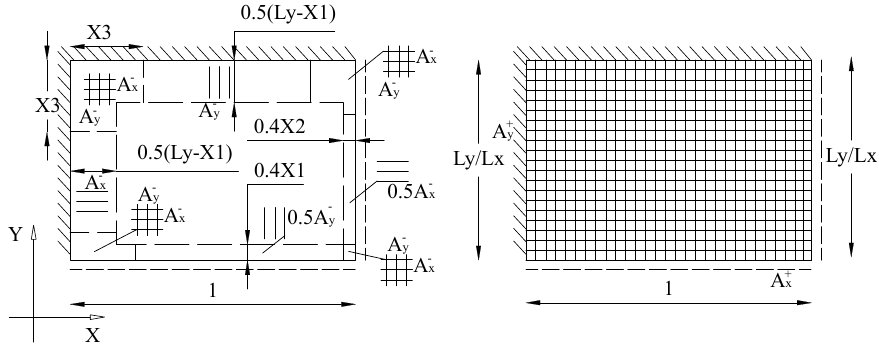
Figure 4. Reinforcement distributions: top reinforcements ( left ) and bottom reinforcements ( right ).